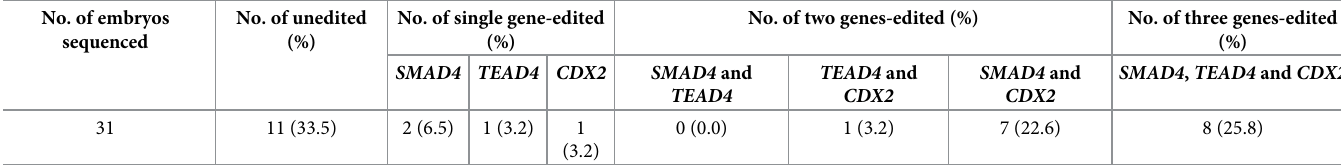
Table 1. Results of multiple genes’ editing in bovine embryos by BE3. No. of embryos No. of unedited sequenced (%)